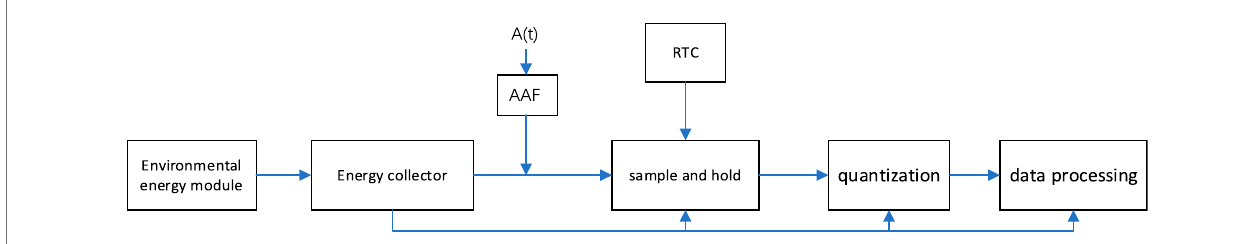
FIGURE 10 | Structural diagram of the heart rate sampling system.